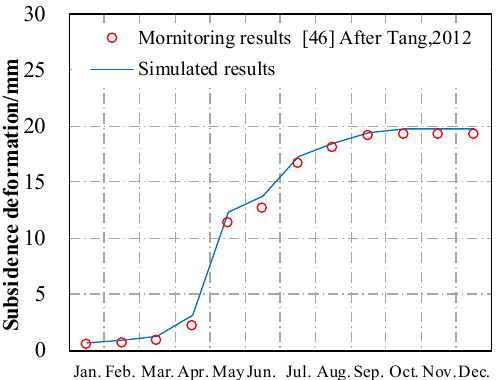
Figure 9. Monitoring and simulated cumulative rutting deformation subsidence.